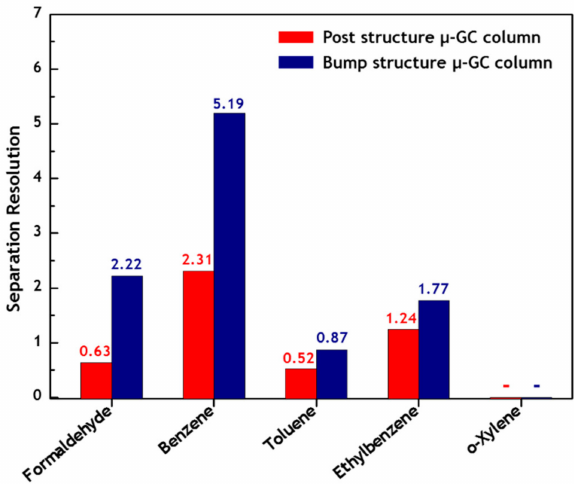
Figure 8. Peak resolutions ( R s ) calculated for formaldehyde, benzene, toluene, ethylbenzene, and o -xylene gases based on the separation results through the µ -GC